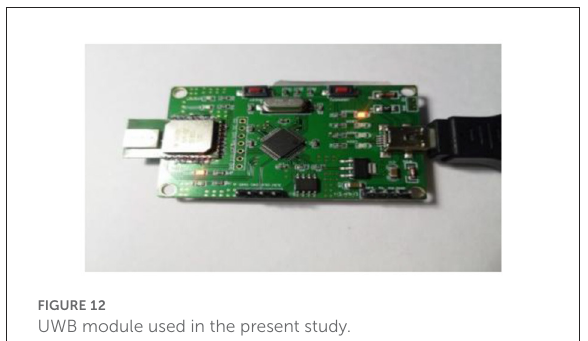
FIGURE12 UWB module used in the present